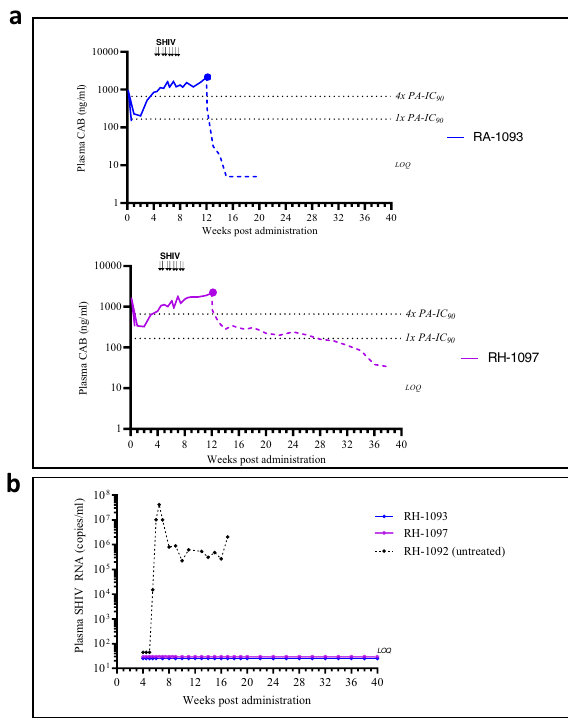
32-week follow-up period. c Long-term protection by CAB ISFI. Two CAB treated (RH-1080 and RH-1048) and one untreated macaque (RH-1084) received rectal SHIVchallengestwiceperweekbetweenweeks14and18postimplantation(upto8 exposures). Animal RH-1048 received six additional SHIV challenges between weeks25and 28 (totalof14 exposures).Arrows indicate SHIV exposures. d Plasma SHIV RNA levels detected by real-time PCR in animals during the challenge period and the 24- to 36-week follow-up